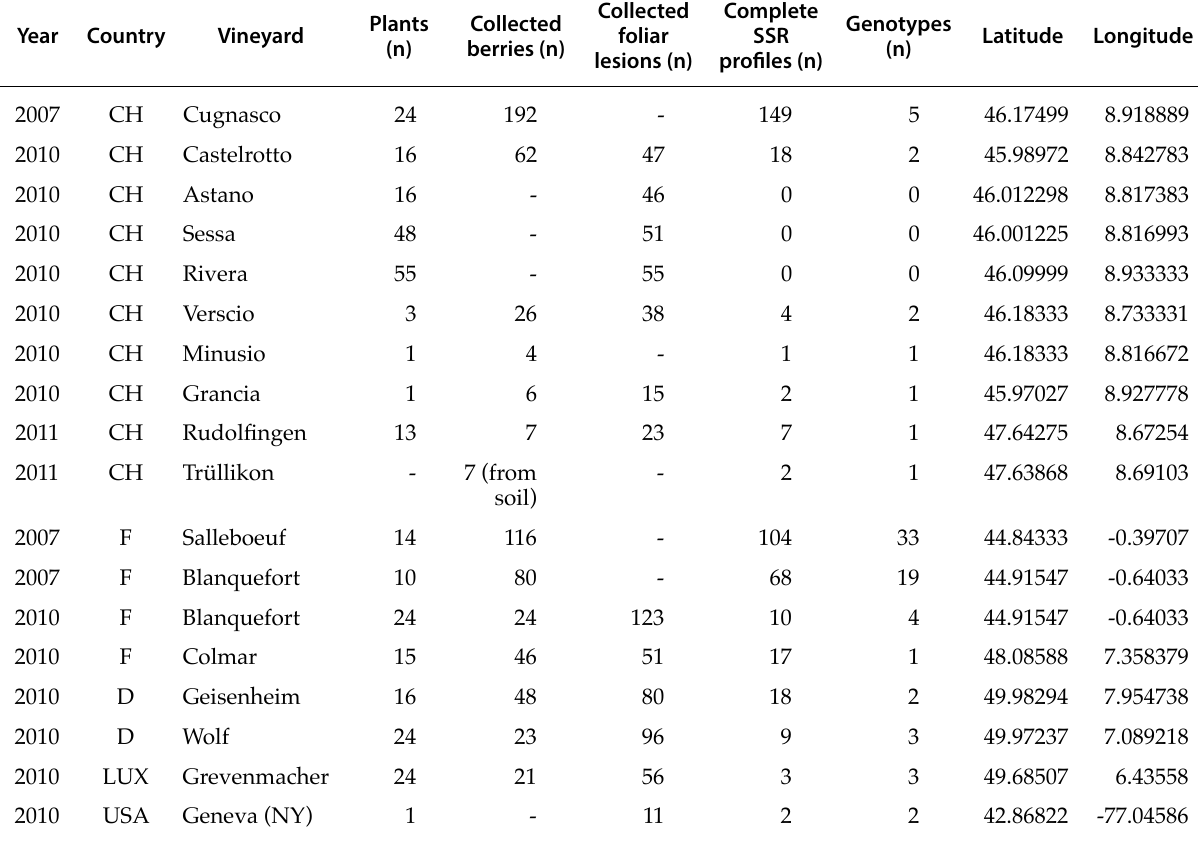
Table 2. Environmental samples investigated in this study. CH: Switzerland; F: France; D: Germany; LUX: Luxembourg and USA: United States of